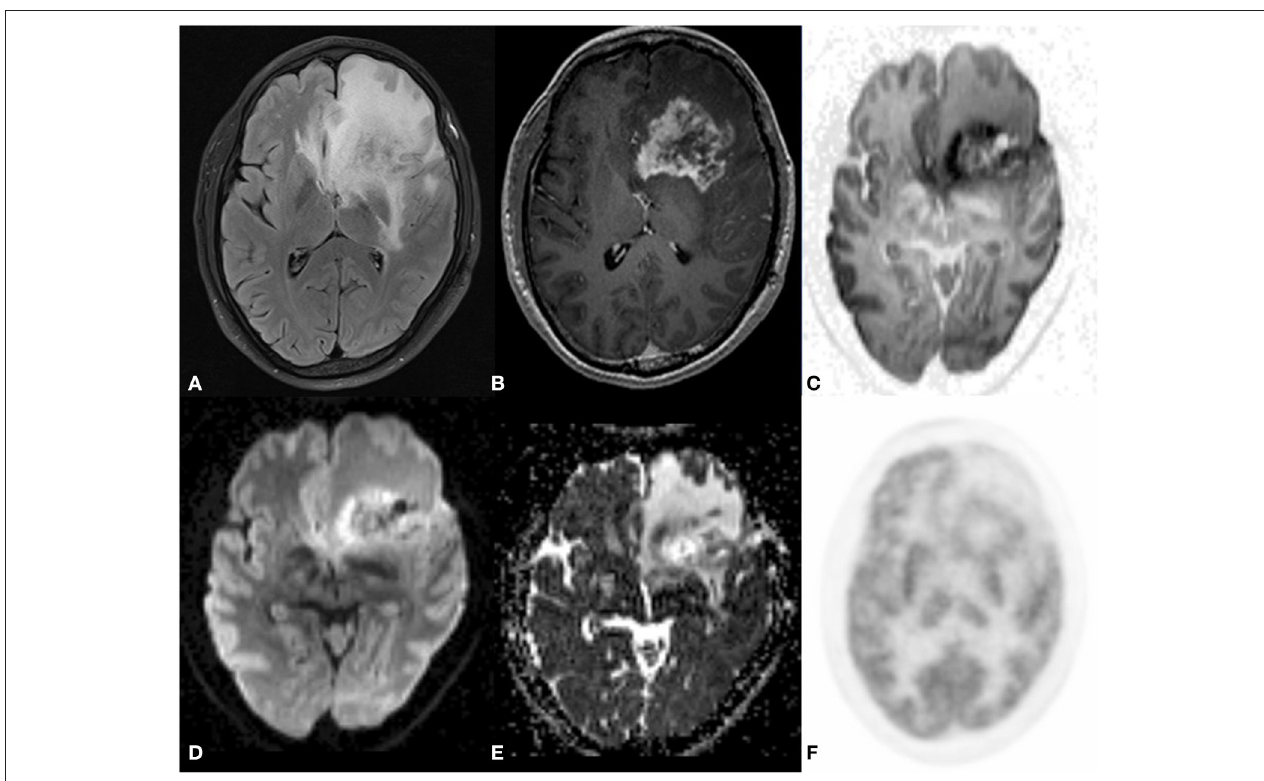
FIGURE 1 | A 43 year old male postoperative case of Glioblastoma IDH mutant in the left frontal lobe, 5 year follow up MRI FDG PET axial images T2-FLAIR (A) post-contrast T1 (B) Inverted DWI (C) DWI b2000 (D) ADC (E) NAC PET (F) showed a T2 heterogeneous hypointense lesion with Swiss cheese and nodular enhancement and elevated perfusion. The lesion shows DWI restriction with hypermetabolism on PET. There is a match on the inverted DWI image and the NAC PET image. Suggestive of